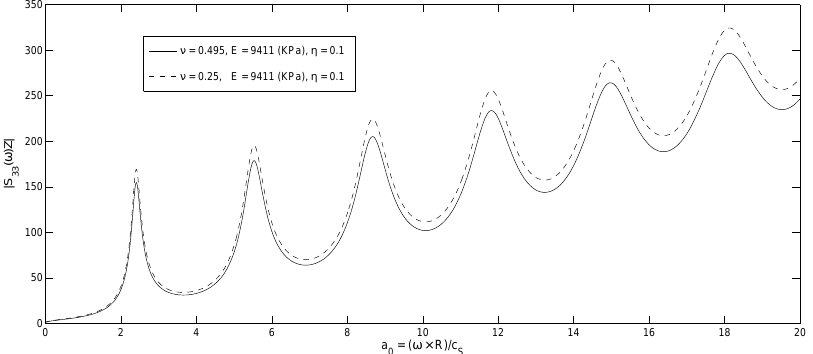
Figure 8. Non-dimensional dynamic stiffness per unit length of an infinite cylinder due to dynamic vertical load in the axial direction for different values of the Poisson ratio ν = 0.25 and ν = 0.495 when the loss factor η = 0.1 and E = 9411 × 10 3